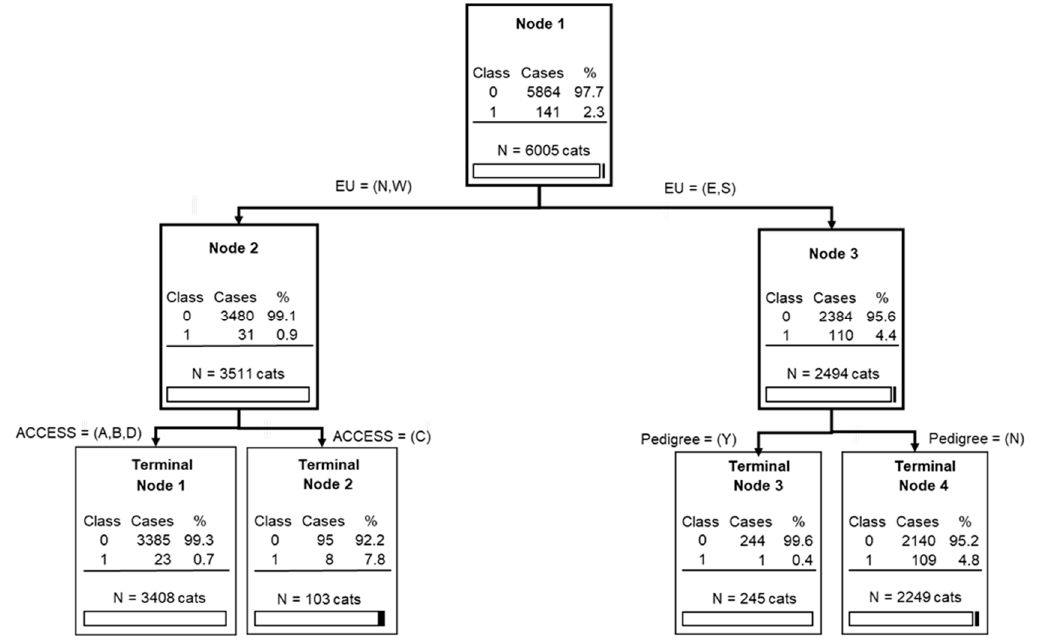
Figure 5. Classification tree analysis for FeLV viraemia. Legend: Class: 0 = negative for FeLV; 1 = positive for FeLV. EU = Europe: N, North; W, West; E, East; S, South. Access: A, Indoor only; B, Indoor and outdoor; C, Outdoor only; D, Not sure. Pedigree: Y, Yes; N, No.